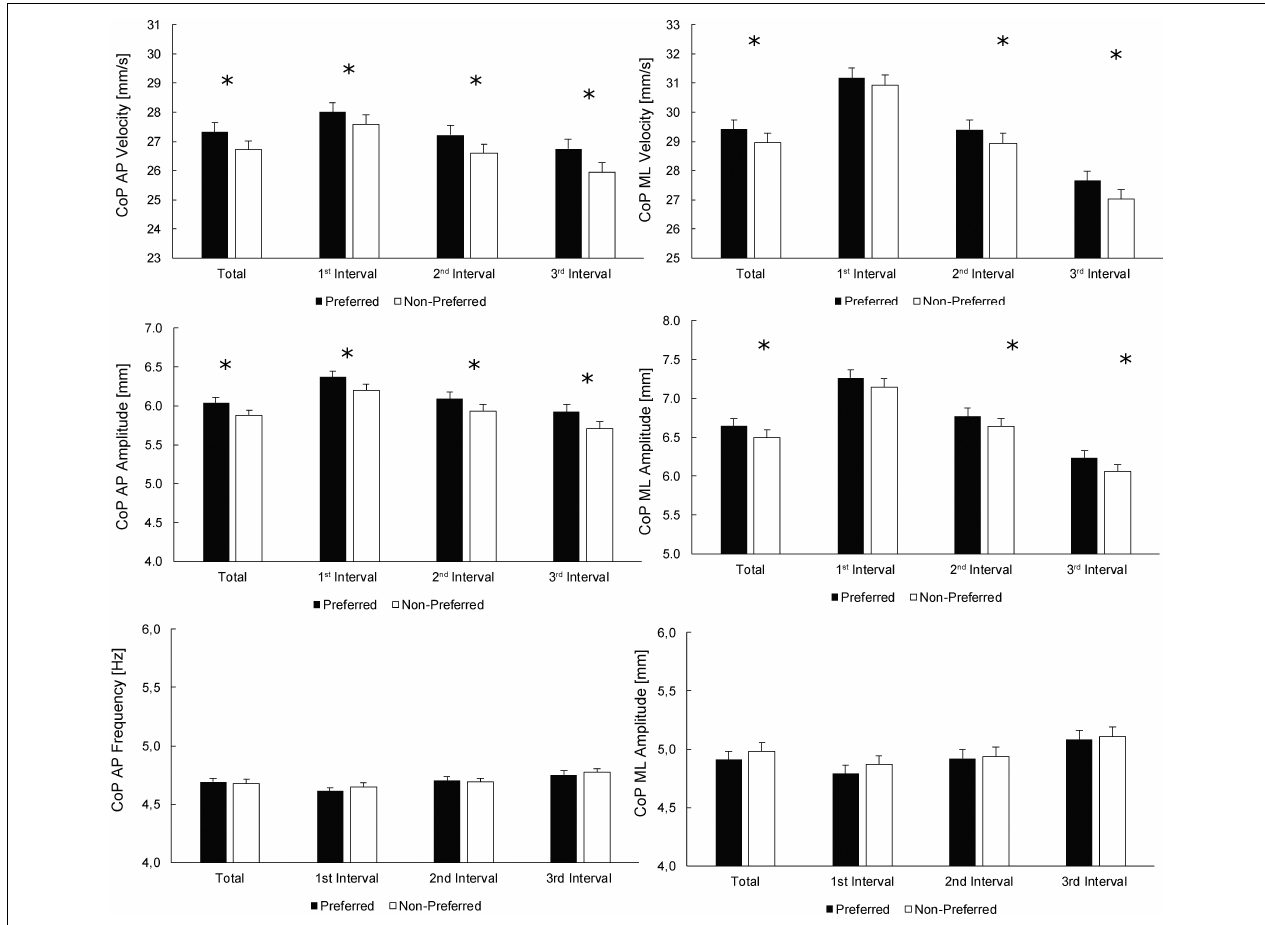
FIGURE 1 | Comparisons between the preferred and non-preferred legs (according to the preference for single-leg jumping). Statistically significant differences between the legs for whole-trial (total; leftmost columns) values, as well as for individual time intervals, are denoted by asterisks. For main effects of leg and time intervals, see Table 2 (top